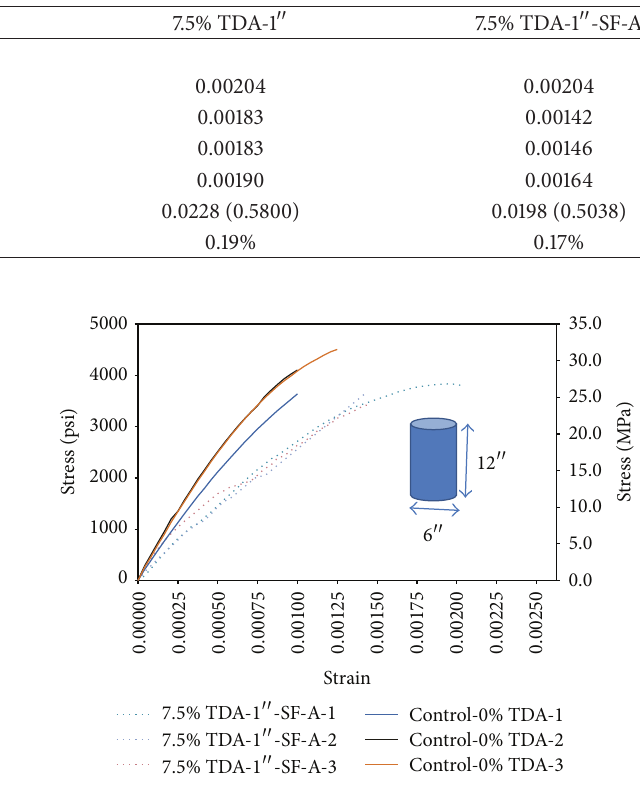
Figure 5: Stress versus strain comparison between control concrete and TDA concrete with silica fume at 28